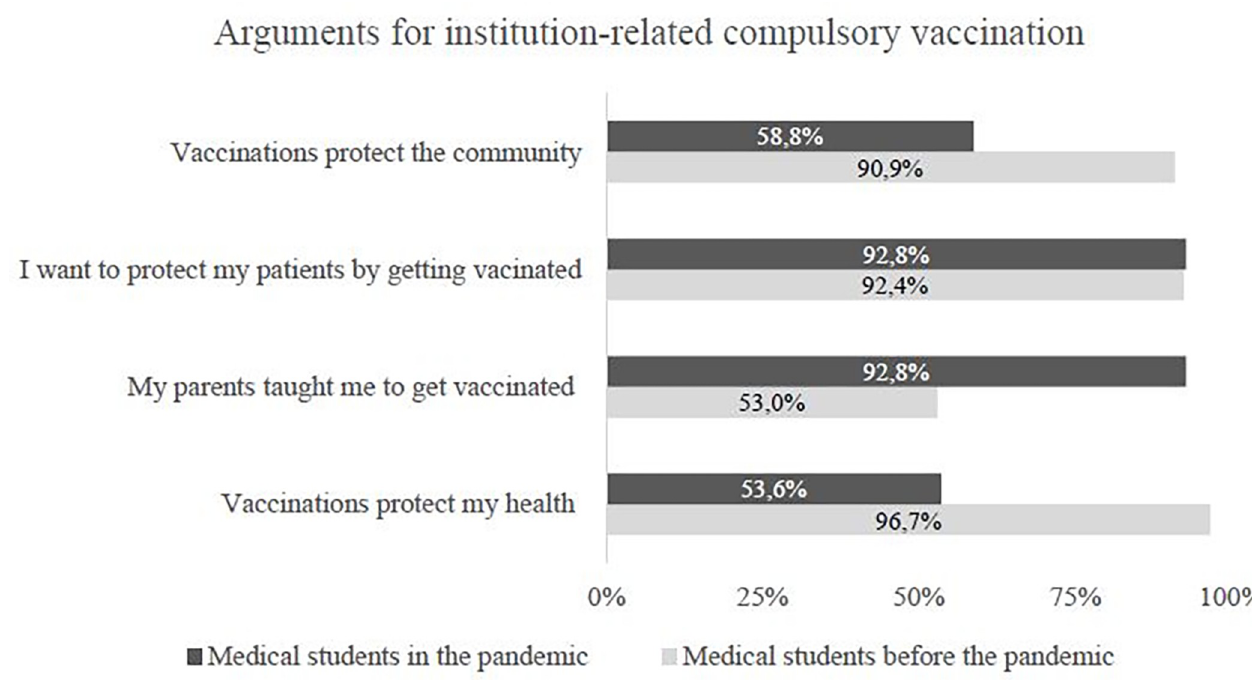
Fig 2. Arguments for institution–related compulsory vaccination in % separated for medical students before and in the pandemic. https://doi.org/10.1371/journal.pone.0273529.g002 PLOS ONE | https://doi.org/10.1371/journal.pone.0273529 August 24,